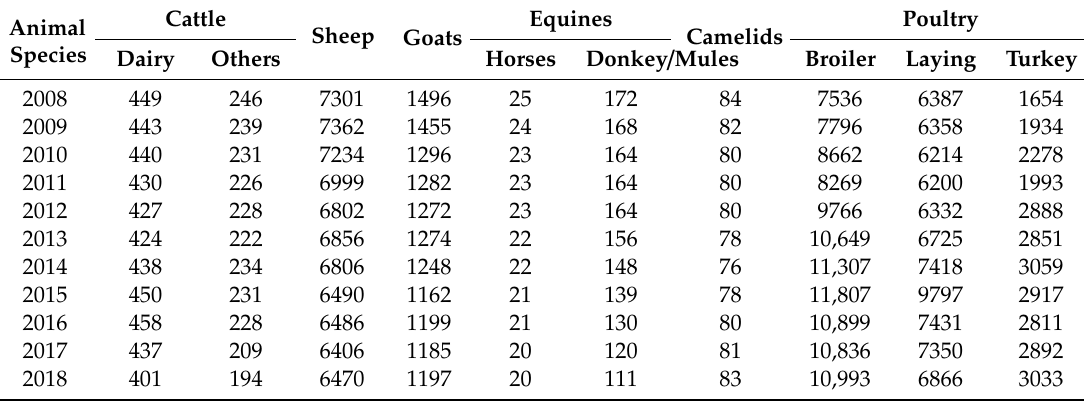
Table3. Averageannualanimalpopulation(thousands)inTunisiaduringthestudiedperiod(2008–2018). Based on data provided by the Tunisian Ministry of Agriculture [4] and applying Equation